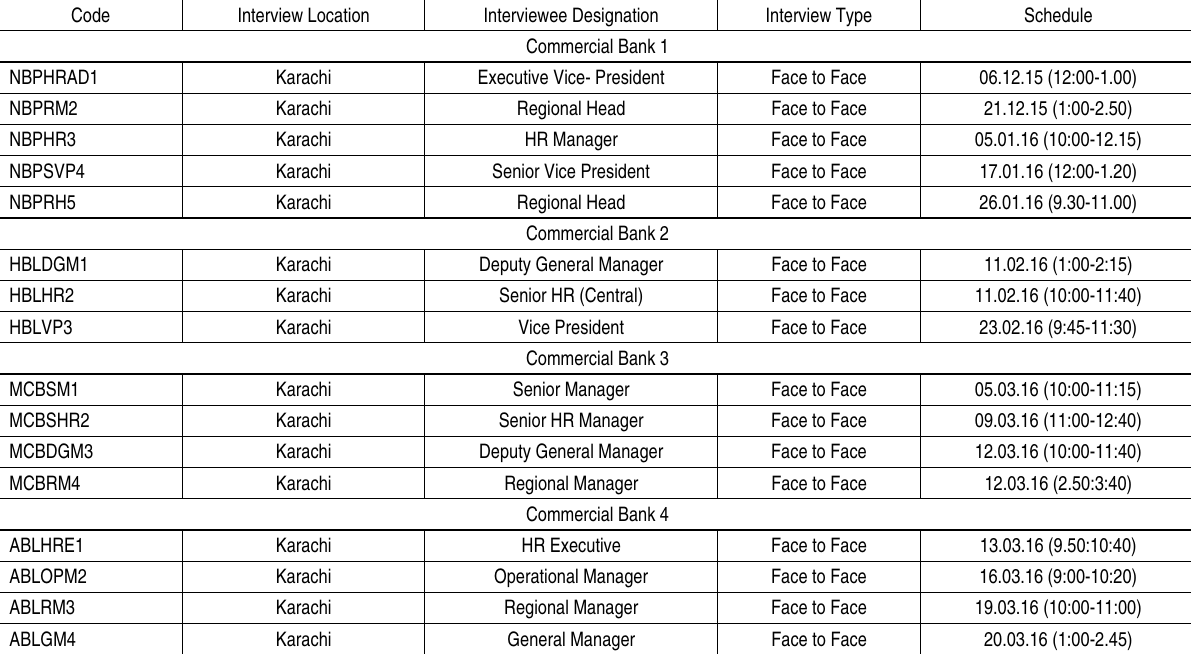
Table 1 . Codification used in the process of obtaining qualitative